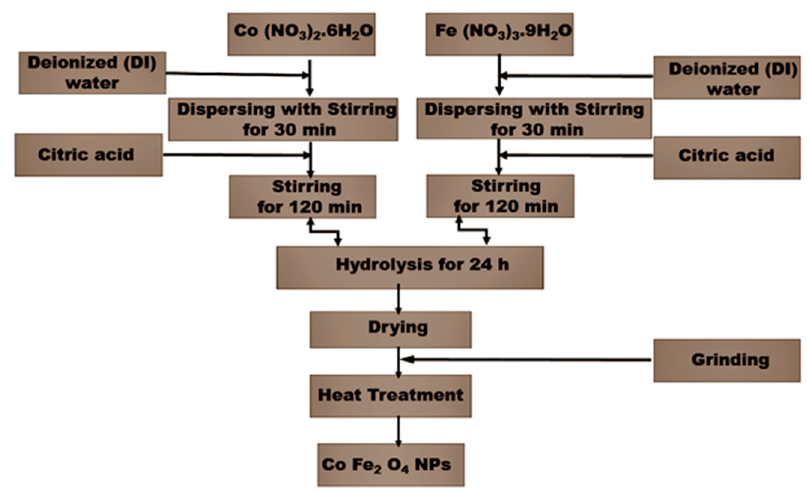
Figure 1. Flow chart for synthesis of pure CoFe2O 4 and W-substituted CoFe 2 O 4 (0.5–0.15%) nanoparticles using a sol-gel method.